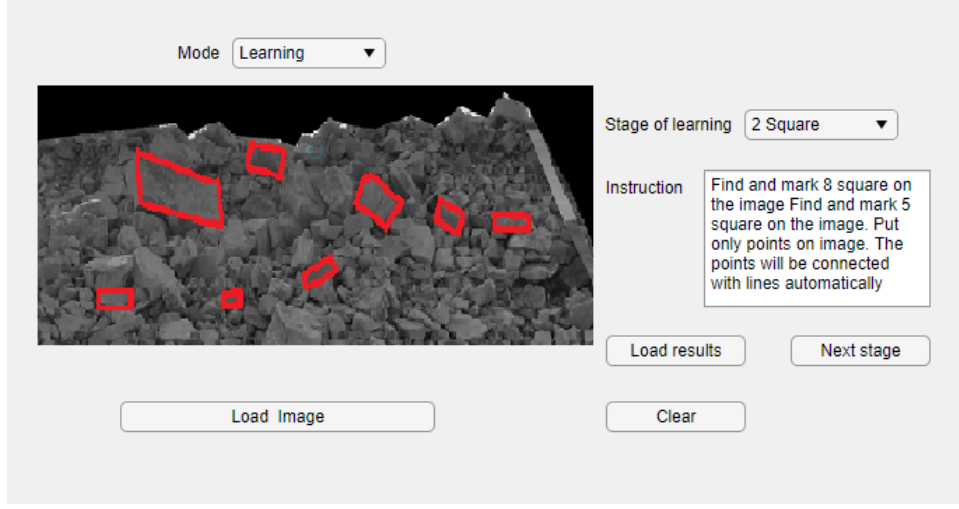
Figure 14. Software interface for defining the fragment form distribution.